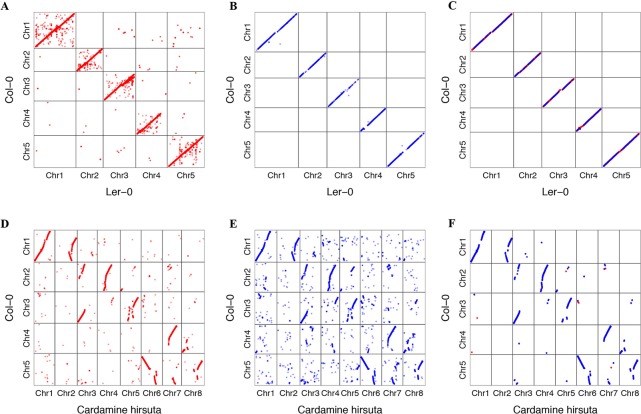
Dot plot of gene position in Col-0 against the position of genes transformed to other de novo assemblies. Dots in red are the result of standard sequence alignment lift over, and those in blue have been realigned by the ZSDP algorithm. (A) Project Arabidopsis thaliana Col-0 genome annotation to the Ler-0 accession genome sequence using standard sequence alignment. (B) Project Col-0 genome annotation to Ler-0 genome sequence of those genes could not be transformed using standard sequence alignment using ZSDP algorithm. (C) Highlighting the syntenic blocks between Col-0 and Ler-0 using the transformed annotations. (D) Project A. thaliana Col-0 annotation to the Cardamine hirsuta genome sequence using standard sequence alignment. (E) Project Col-0 annotation to C. hirsuta genome sequence of those genes could not be transformed using standard sequence alignment using ZSDP algorithm. (F) Highlighting the syntenic blocks between A. thaliana Col-0 and C. hirsuta using the transformed annotations.